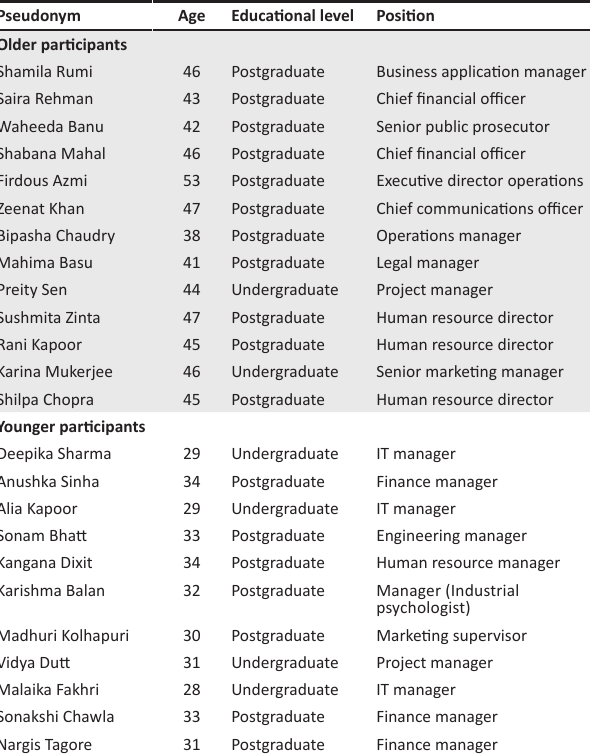
TABLE 1: Biographical data of